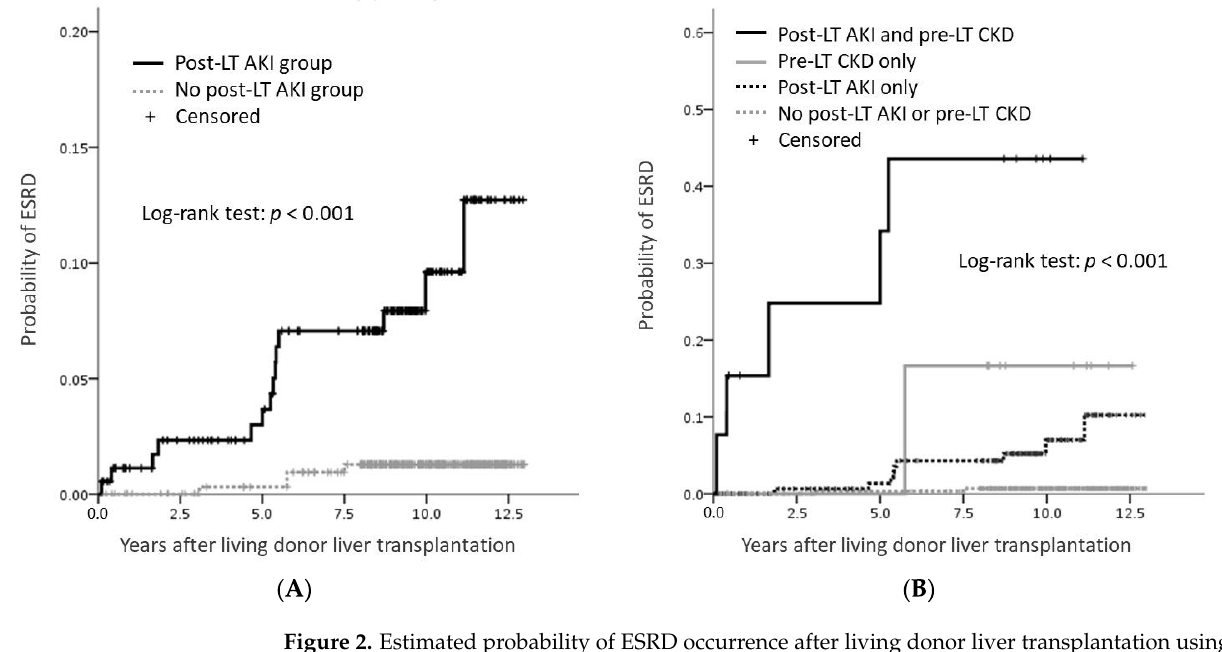
Figure 2. Estimated probability of ESRD occurrence after living donor liver transplantation using the Kaplan–Meier method. ( A ) Curves by post-LT AKI status. ( B ) Curves by post-LT AKI and pre-LT CKD status. Table 4. Risk Factors of ESRD after Living Donor Liver Transplantation by Cox Regression Analysis. Univariate